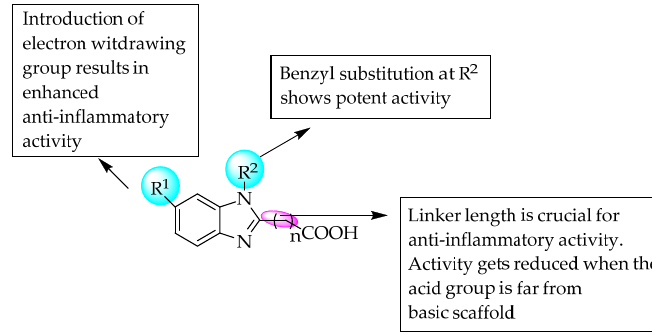
Figure 37 . SARs of sugar-linked benzimidazoles. A series of 1,2,6-trisubstituted benzimidazoles were synthesised and evaluated for anti-inflammatory activity by Thakurdesai et al. in 2007 [58]. The C2 position was sub- stituted with various carboxylic acids, whereas the C6 position was substituted with electron-rich or poor groups. The activity mainly depends on the groups substituted at C6 of benzimidazole. The activity was inversely related to the length of the linker be- tween the carboxyl group and C2 of benzimidazole (Figure 38). The substitution of the benzyl group at the 1-position enhanced the anti-inflammatory action.